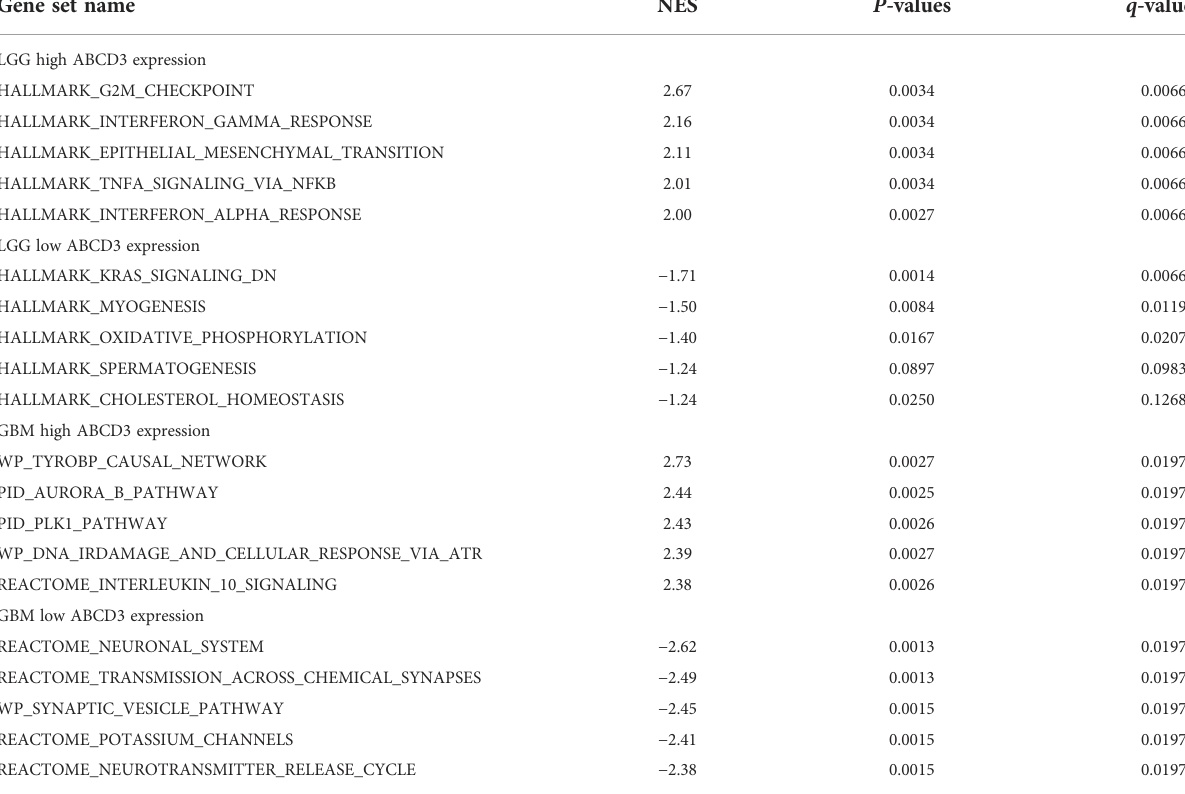
TABLE 1 Gene sets enriched in different ABCD3 expression